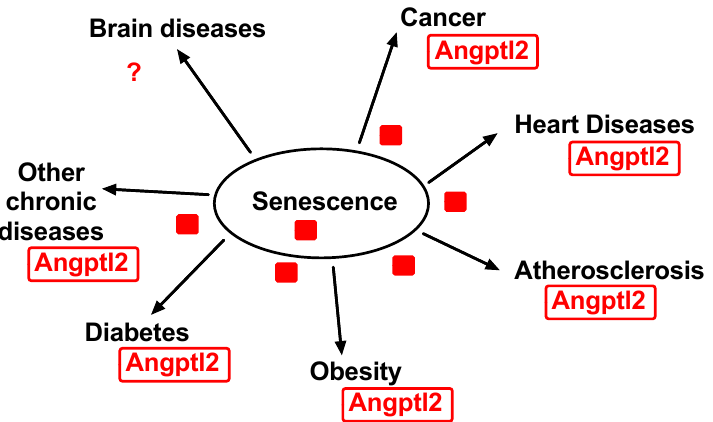
Figure 3. Senescence-related diseases. Angptl2 contributes to or is associated with all chronic diseases related with senescence, such as cancer, cardiovascular diseases, obesity and diabetes, and many other chronic diseases. The role of angptl2 in brain diseases and neurodegenerative diseases is less clear.